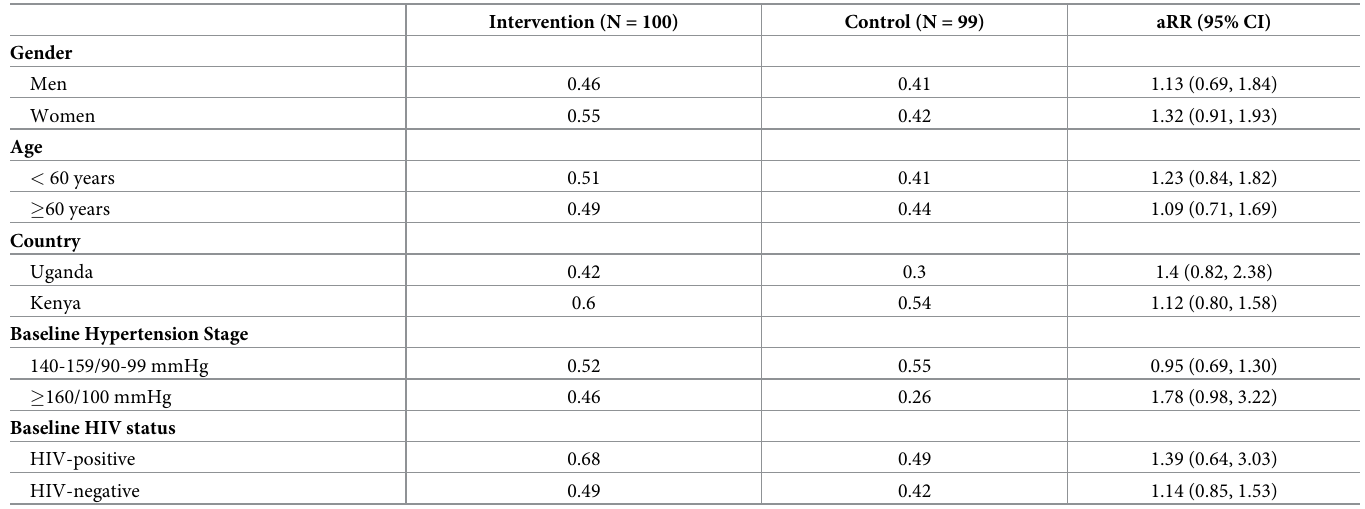
Table 4. Hypertension control at 3 months, stratified by baseline participant